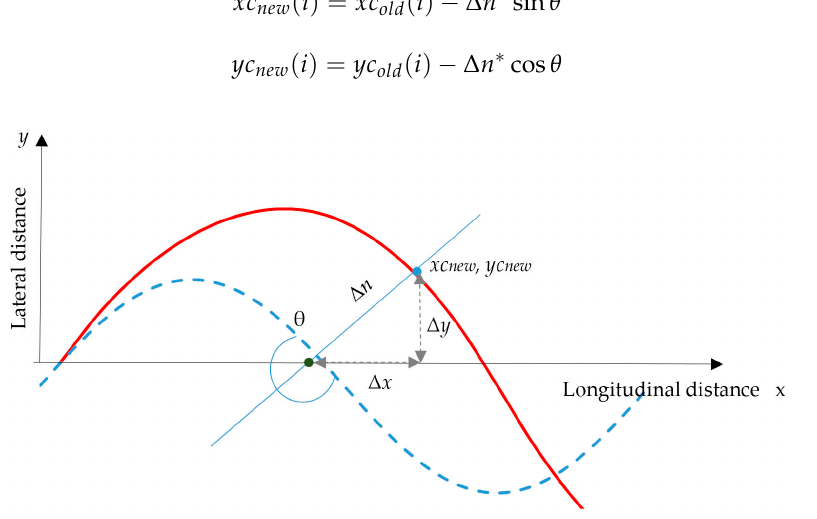
Figure 3. Schematic representation of the centreline migration in plain view (blue: previous centreline, red: new centreline).